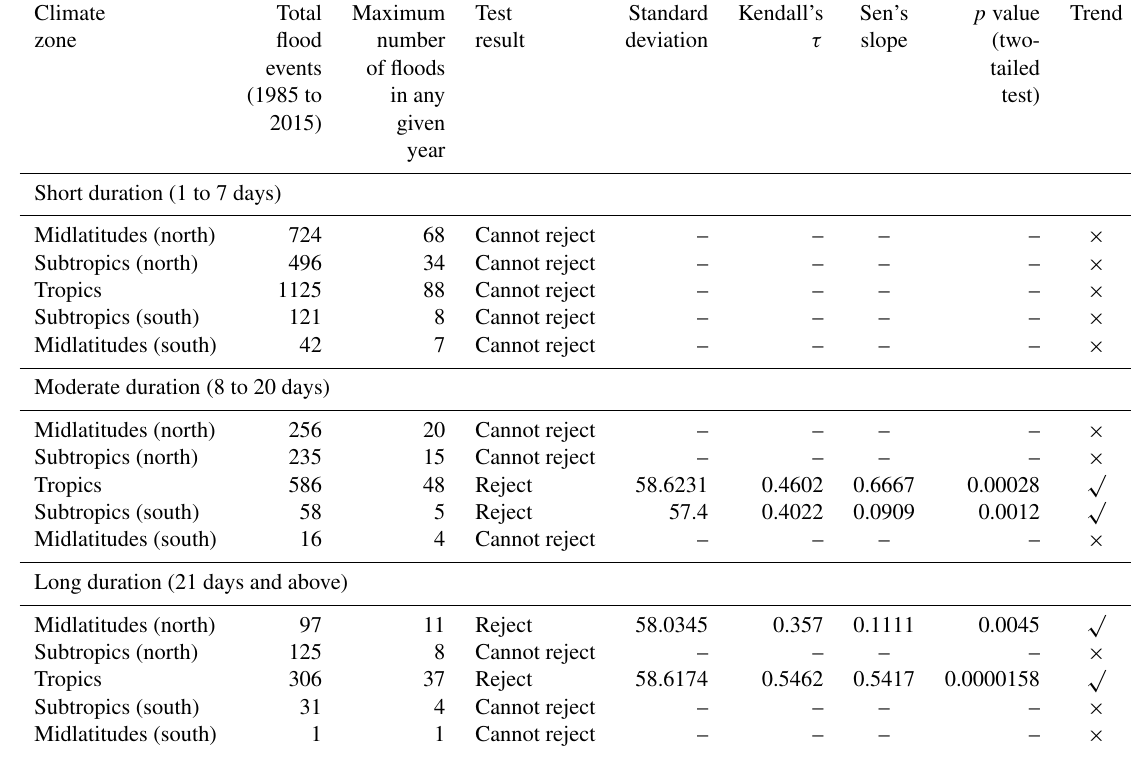
Table 7. Summary of trend analysis (Mann–Kendall test with a significance level α = 0.05) on three flood classes: short, moderate, and long durations of flood events over five latitudinal